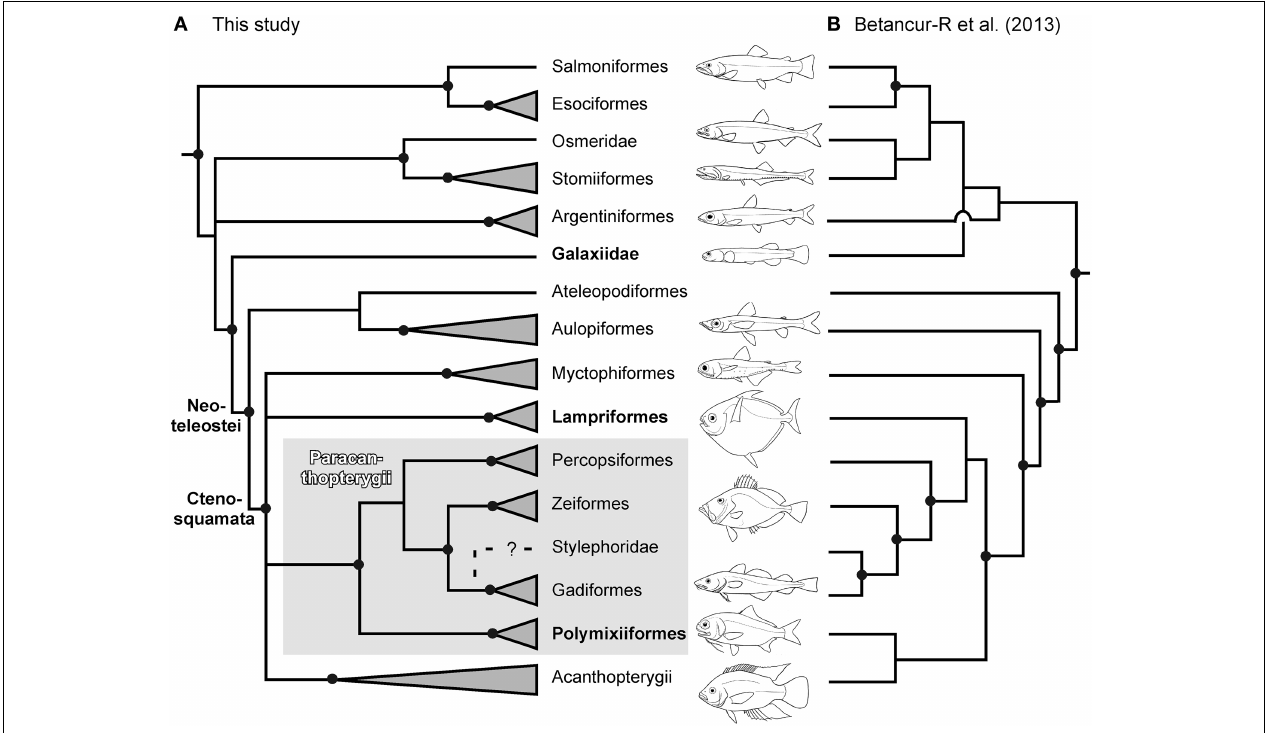
FIGURE 3 | A summary of the new hypothesis (strict consensus tree from Figures 1A,B) (A) (this study) for the evolutionary relationships among the main lineages of euteleost fishes. This is compared with the